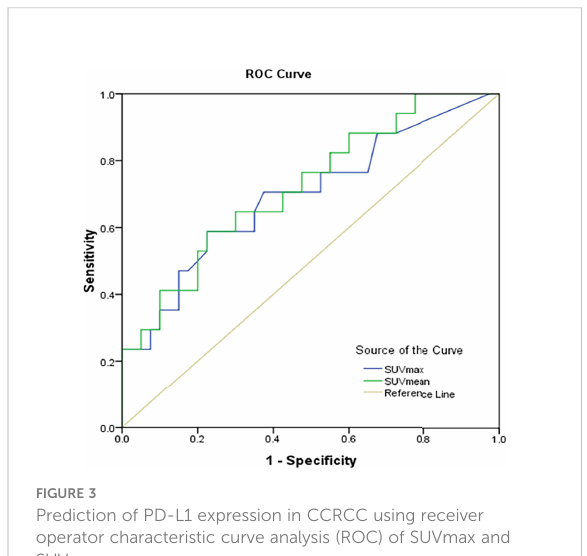
FIGURE 3 Prediction of PD-L1 expression in CCRCC using receiver operator characteristic curve analysis (ROC) of SUVmax and SUVmean.